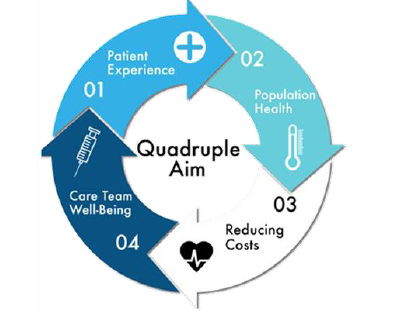
Fig.1. Crossing A4A approach left [10] and Healthcare Quadruple Aim